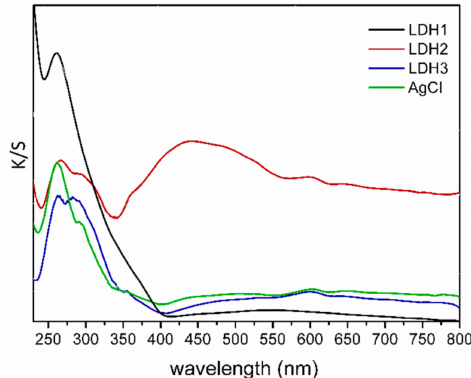
Figure 4. UV–Vis absorption spectra in Kubelka-Munk units of LDH1 (black line), LDH2 (red line), LDH3 (blue line) and AgCl (green